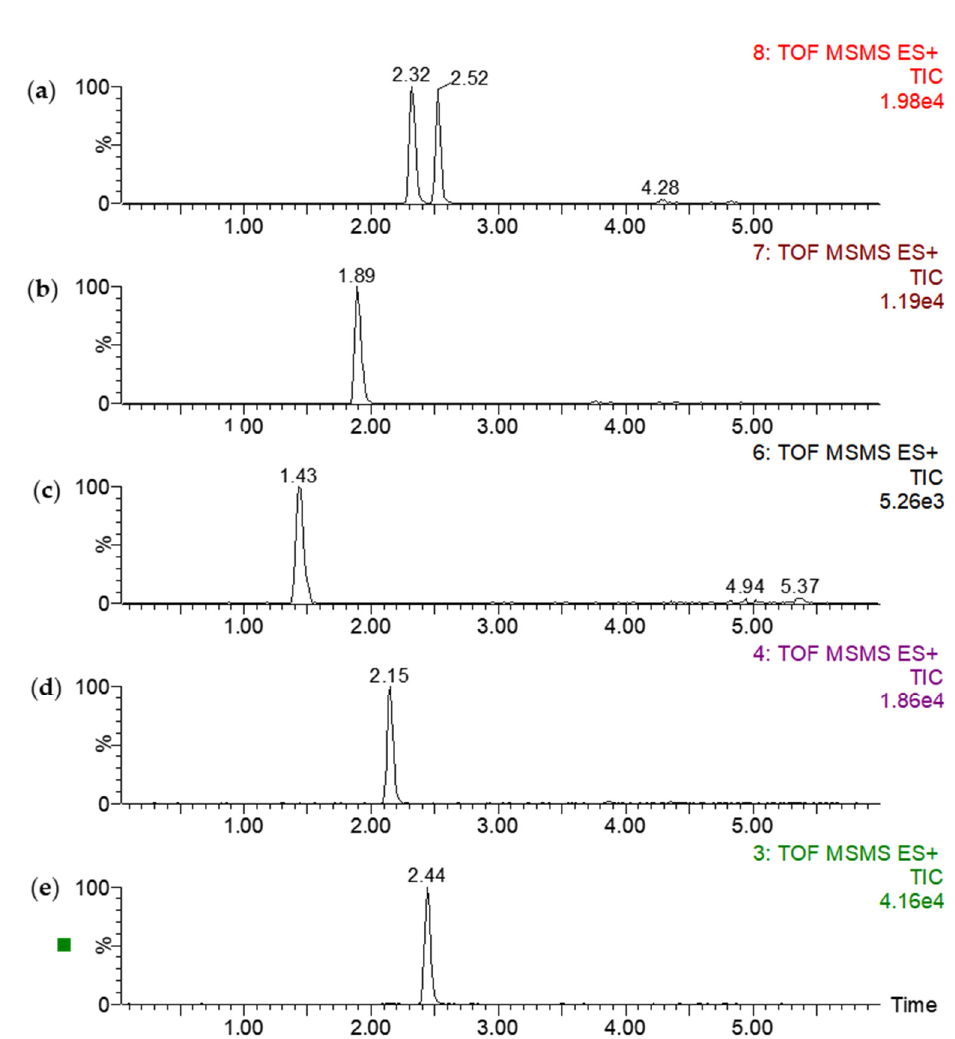
Figure 2. Chromatogram of six steroid hormone mixtures by LC–MS, ( a ) 11-deoxycorticosterone and 17-hydroxyprogesterone, ( b ) 11-deoxycortisol, ( c ) cortisol, ( d ) androstenedione, and ( e ) testosterone. Analyte standards: 200 ng/mL for each analyte. These steroids were detected by SRM mode and processed using MassLynx 4.1 software.